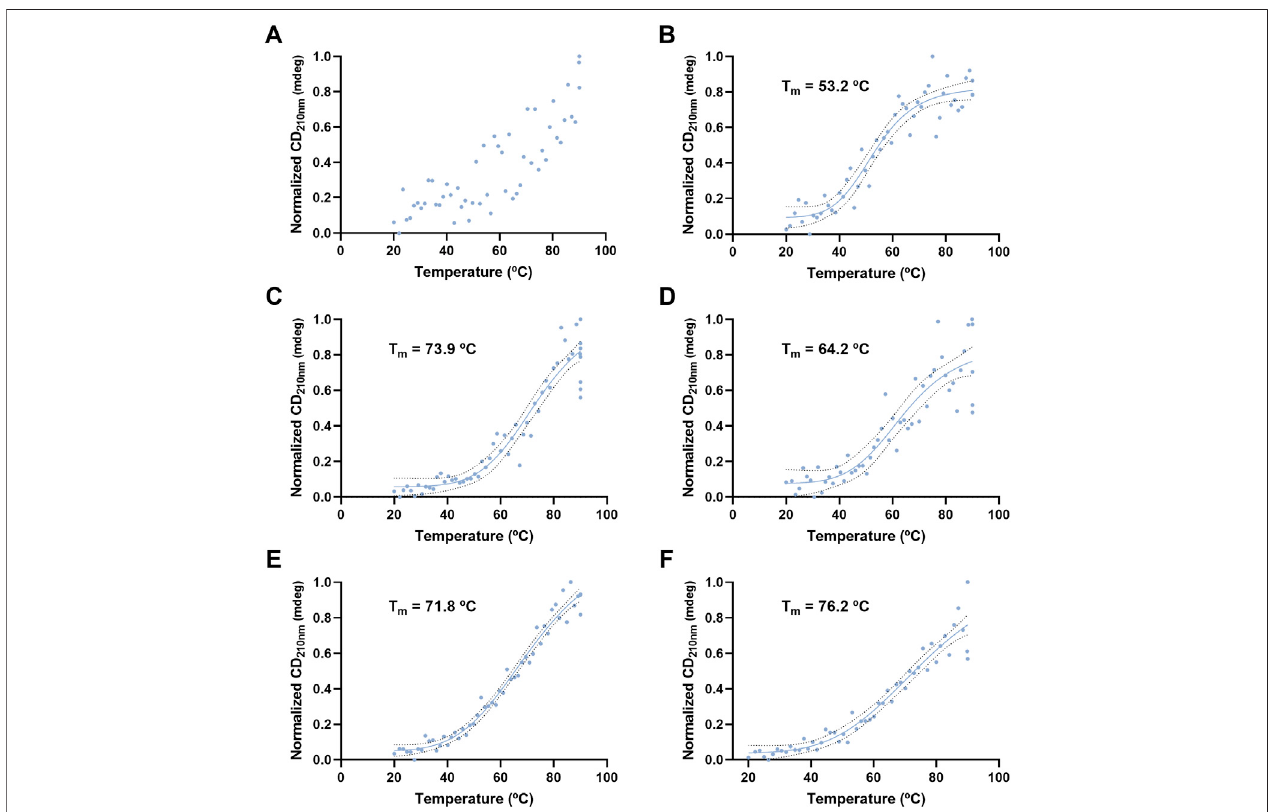
FIGURE 8 | Thermal stress analysis of in fl uenza VLPs using circular dichroism. Temperature ramp for VLP secondary structure analysis during thermal stress. CD signalwasfollowedat210 nm.Datawasnormalized(0 – 1)forplotting.mdeg:milidegrees. (A) H1MonoVLP, (B) H1PentaVLP, (C) H3MonoVLP, (D) H3PentaVLP, (E) B Mono VLP, (F) B Penta VLP. Indirect measurement of T m values was estimated by interpolation applying a sigmoidal